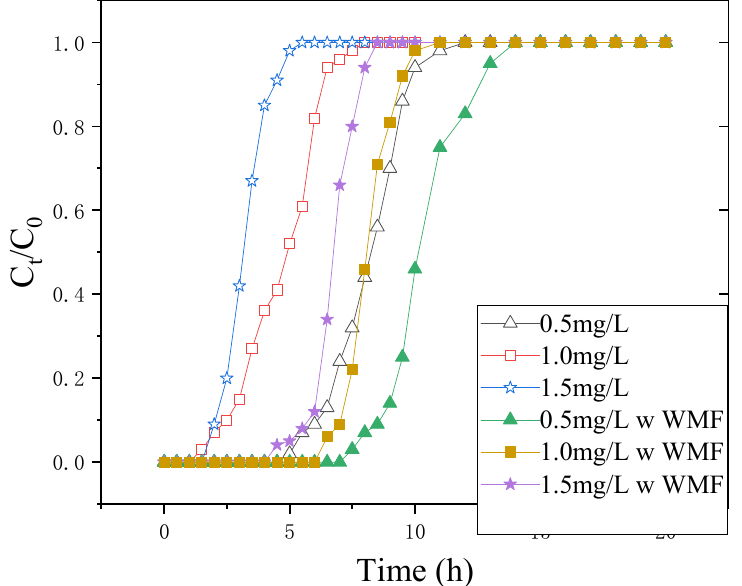
Figure 4. Breakthrough curves of Sb(III) removal by nZNI/AC for different concentrations. Flow rate = 10 mL · min − 1 ; H = 20 cm; pH = 7; C 0 = 0.5, 1, 2 mg · L − 1 . By lowering the concentration of Sb(III) ions in the feed, the treated volume of feed metal concentration was increased with the pushing of breakthrough curves to the right.